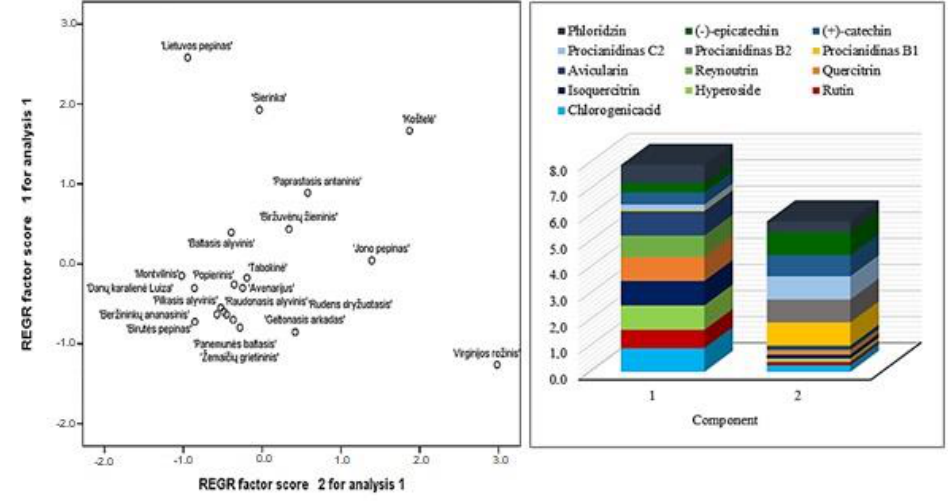
Figure 7 Figure 7. Analysis of the main components of phenolic compounds in apple